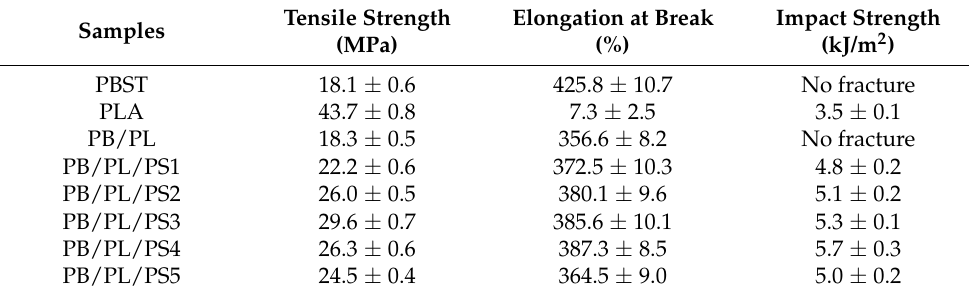
Table 4. Data for the mechanical properties of PBST/PLA blends.